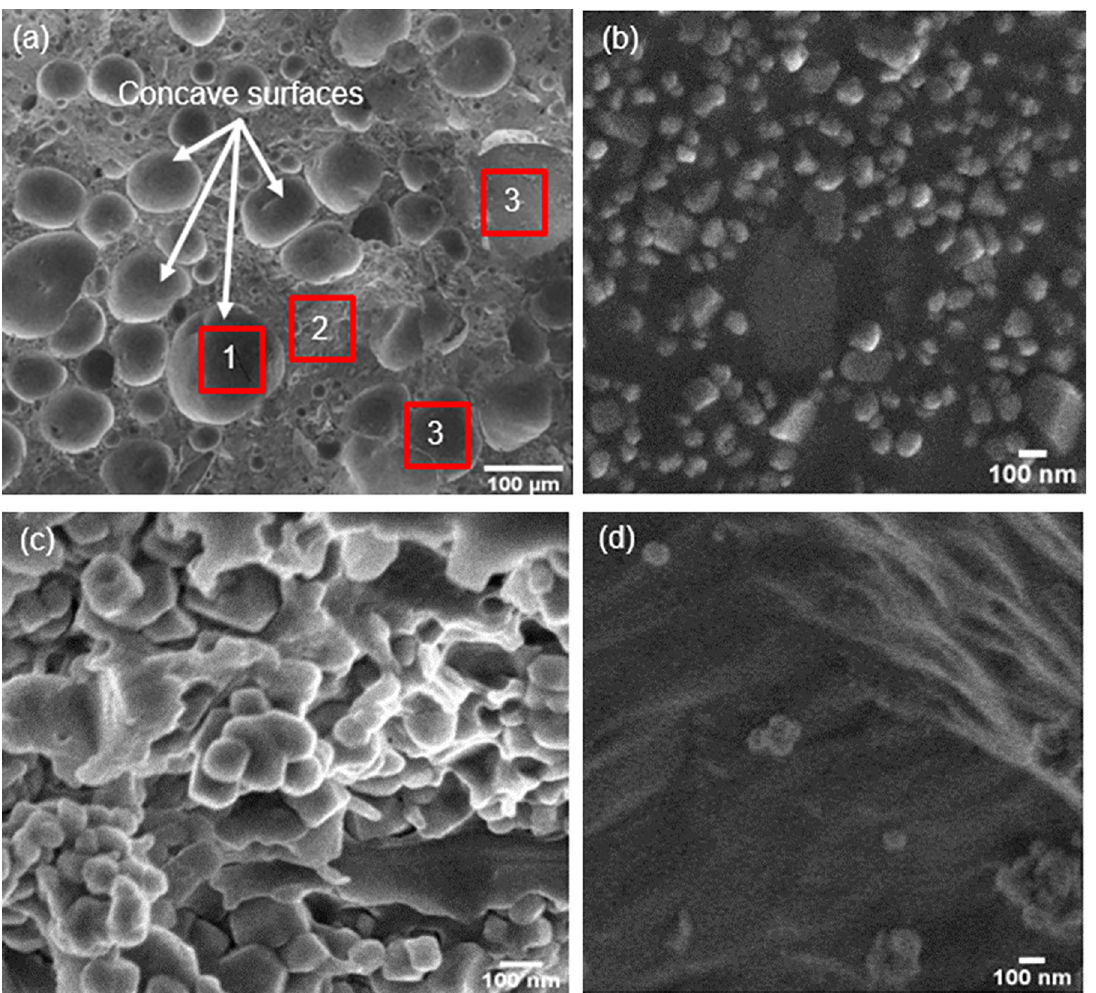
Figure 8. SEM image of Sikadur 30 sample after tensile test. Figures 8b,c and d are magnified images of regions 1, 2 and 3,